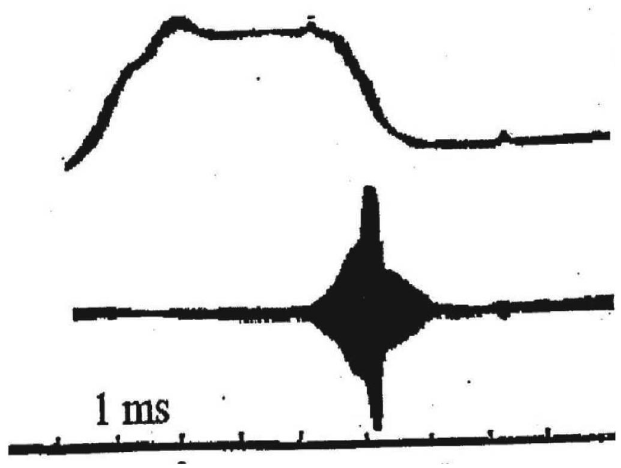
FIG. 1. Observation of an electron-driven instability at the INP PSR in 1965 [12]; beam intensity (top curve) and radial beam position (bottom curve) as a function of time (1 ms per